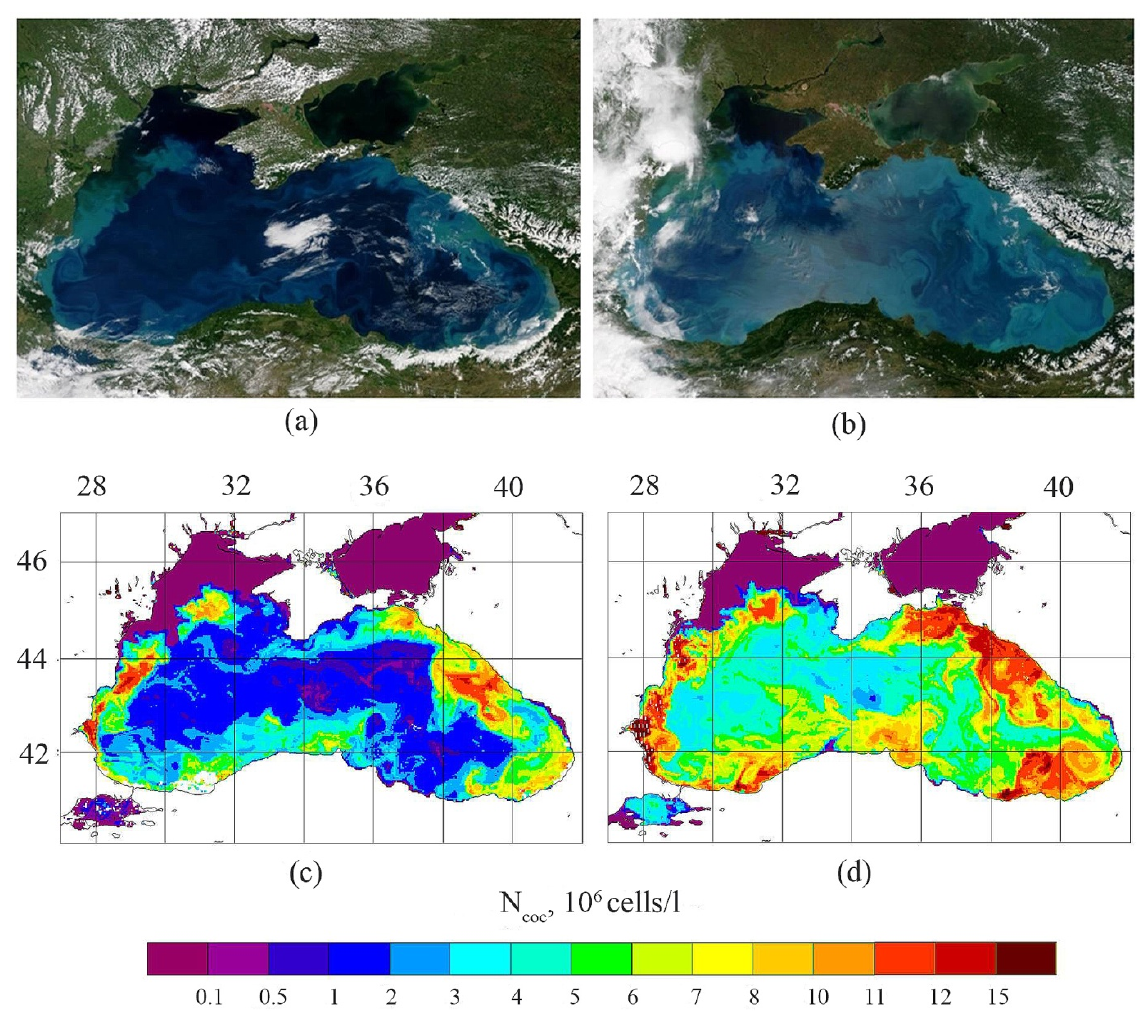
Figure 10. Coccolithophore blooms in the Black Sea in May (29 May 2017) and June (8 June 2017) ( a , b )—true color (https://visibleearth.nasa.gov, accessed on 15 December 2021), ( c , d )—(N coc ) number of coccolithophores by the regional algorithm.